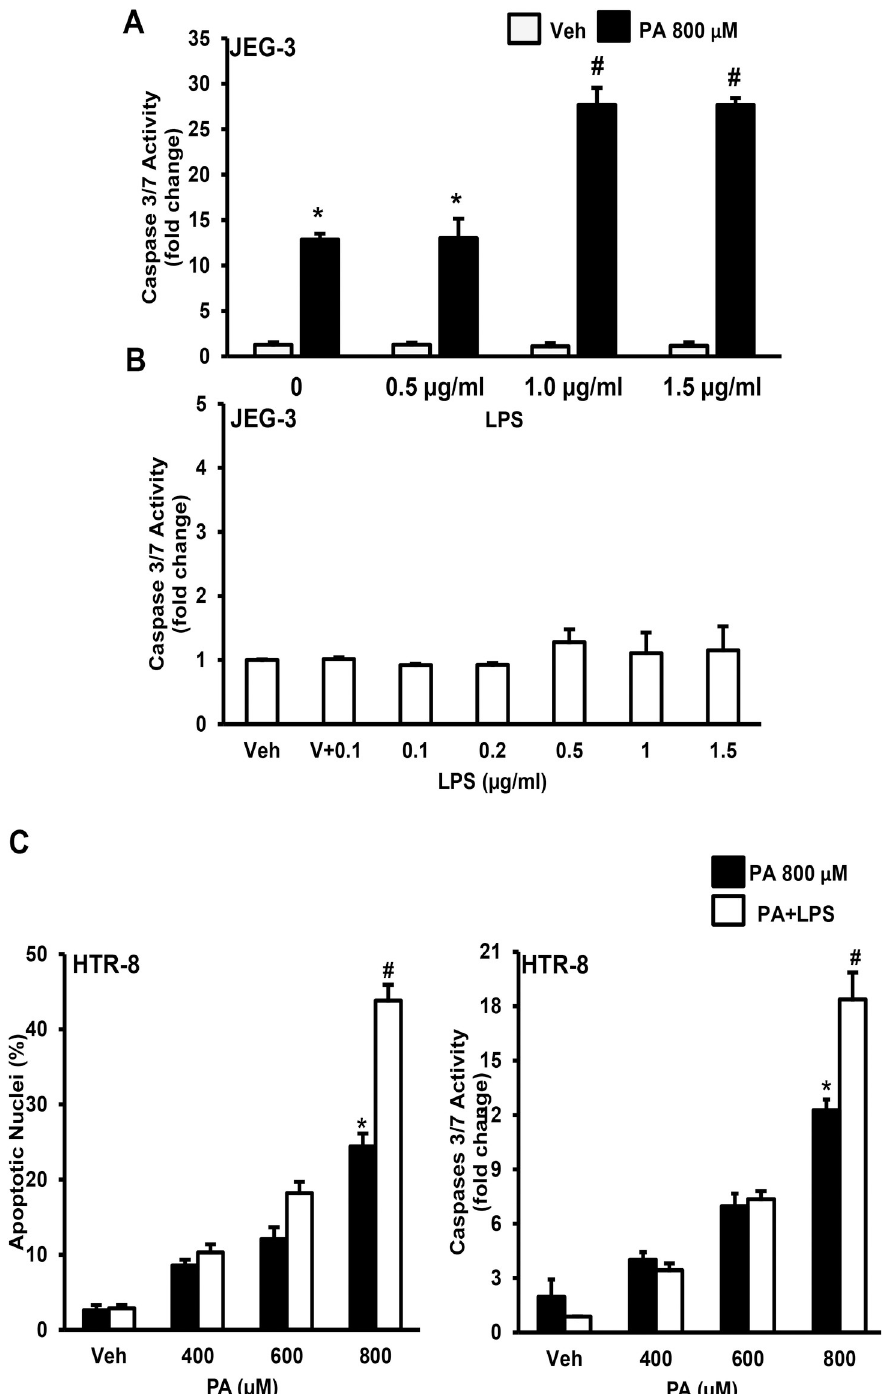
Fig 4. LPS aggravates FFA-induced trophoblast lipoapoptosis. JEG-3 cells were treated with 800 μ M of palmitate (PA) showed increased caspase 3/7 activity. (A) Co-treatment of PA with physiological concentration of LPS (1.0– 1.5 μ g/ml) results in aggravation of PA-induced trophoblast lipoapoptosis; (B) JEG-3 cells treated with LPS alone (0.1– 1.5 μ g/ml) did not alter caspase 3/7 activity compared to vehicle (Veh) treated cells; (C) Percent apoptotic nuclei and caspase 3/7 activity were elevated in HTR-8 cells with co-treatment of PA (800 μ M) and LPS (1.0 μ g/mL) compared to 800 μ M of palmitate alone treated cells. These data represent the mean ± sem, n = 4 and � P < 0.05 compared to vehicle, #p < 0.05 compared to PA alone